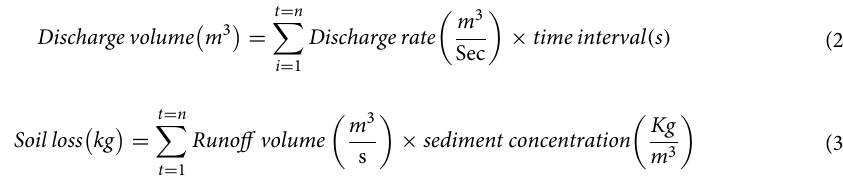
Groundwater table and cropping intensity. The groundwater table in dug wells was monitored in eight bench- mark watersheds (# 16, 18, 19, 21, 22, 23, 24, 25). Nearly 50–300 wells per site were monitored from pre-project stage to post intervention using water level indicators on a monthly basis 17,19,20 . In addition, the number of pumping hours and area irrigated during rainy and postrainy seasons were monitored. The change in land use due to RWH interventions was mapped through household surveys and ground data collection. The area under agriculture and fallow lands was mapped for both rainy and postrainy seasons before and after project interven- tion. Crop yield, cost of cultivation and income. Changes in land use and cropping intensity due to RWH interven- tions were captured through ground surveys before and after project implementation. In addition, about 2000 crop cutting studies (80–100 per site per season) were undertaken to assess the impact of best management practices on crop yield 41,42 . An area of 3 m × 3 m was demarcated with three replications. Crop was harvested at maturity to measure grain yield. In addition, cost of cultivation (farm inputs, irrigation, labour, energy) data was collected through household surveys of selected farmers before and after the interventions and net income was calculated 42,43